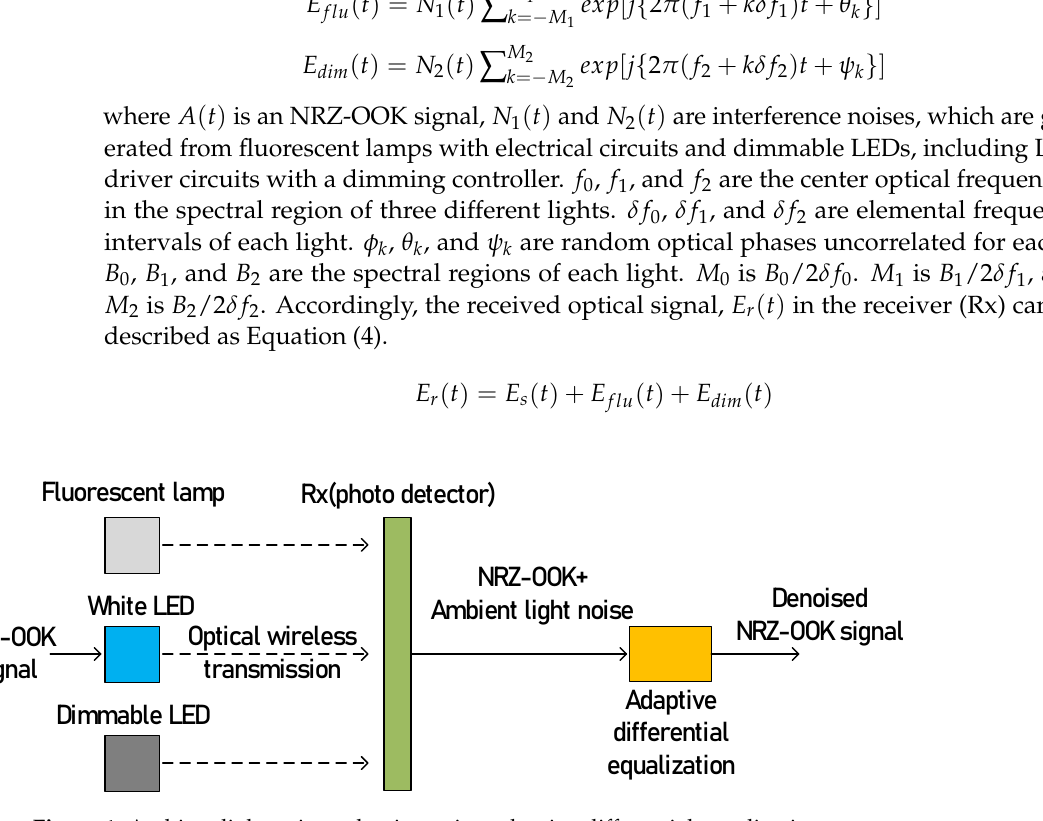
Figure 1. Ambient light noise reduction using adaptive differential equalization.